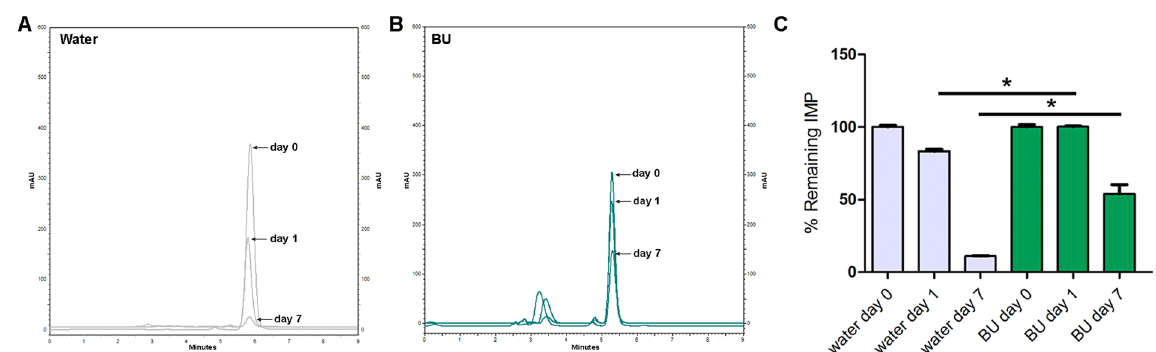
Figure 7. Representative chromatograms obtained of imipenem (IMP) dissolved in water ( A ) and in BU ( B ) of samples of 4 mg/ml after 0, 1 and 7 days. ( C ) Shows chromatogram quantification. Results are expressed as median ± SEM of three experimental